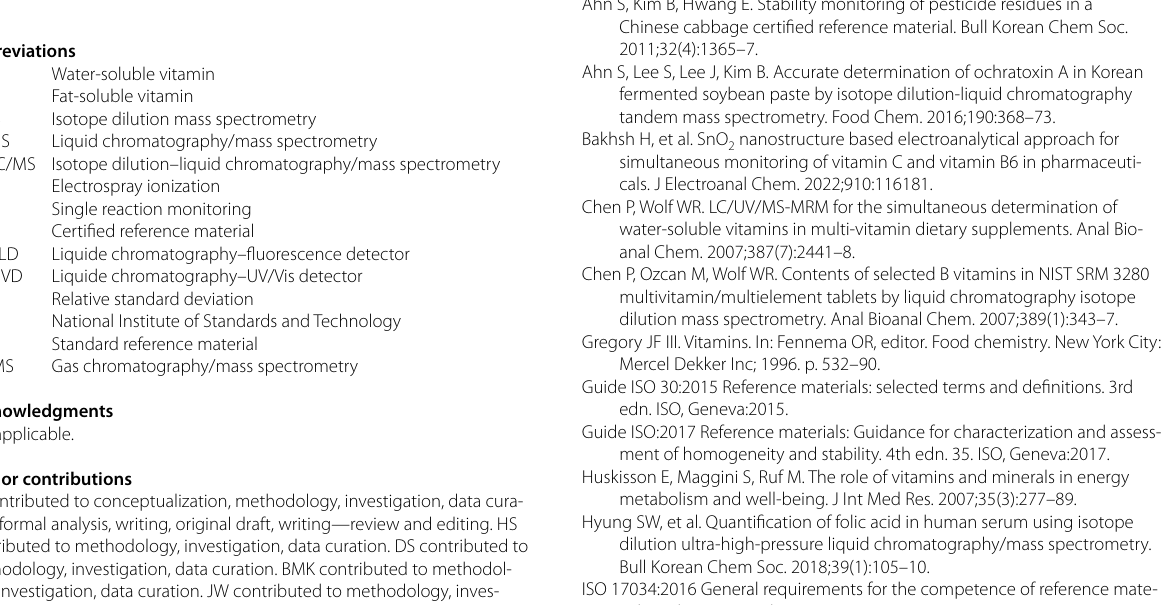
a The number following “